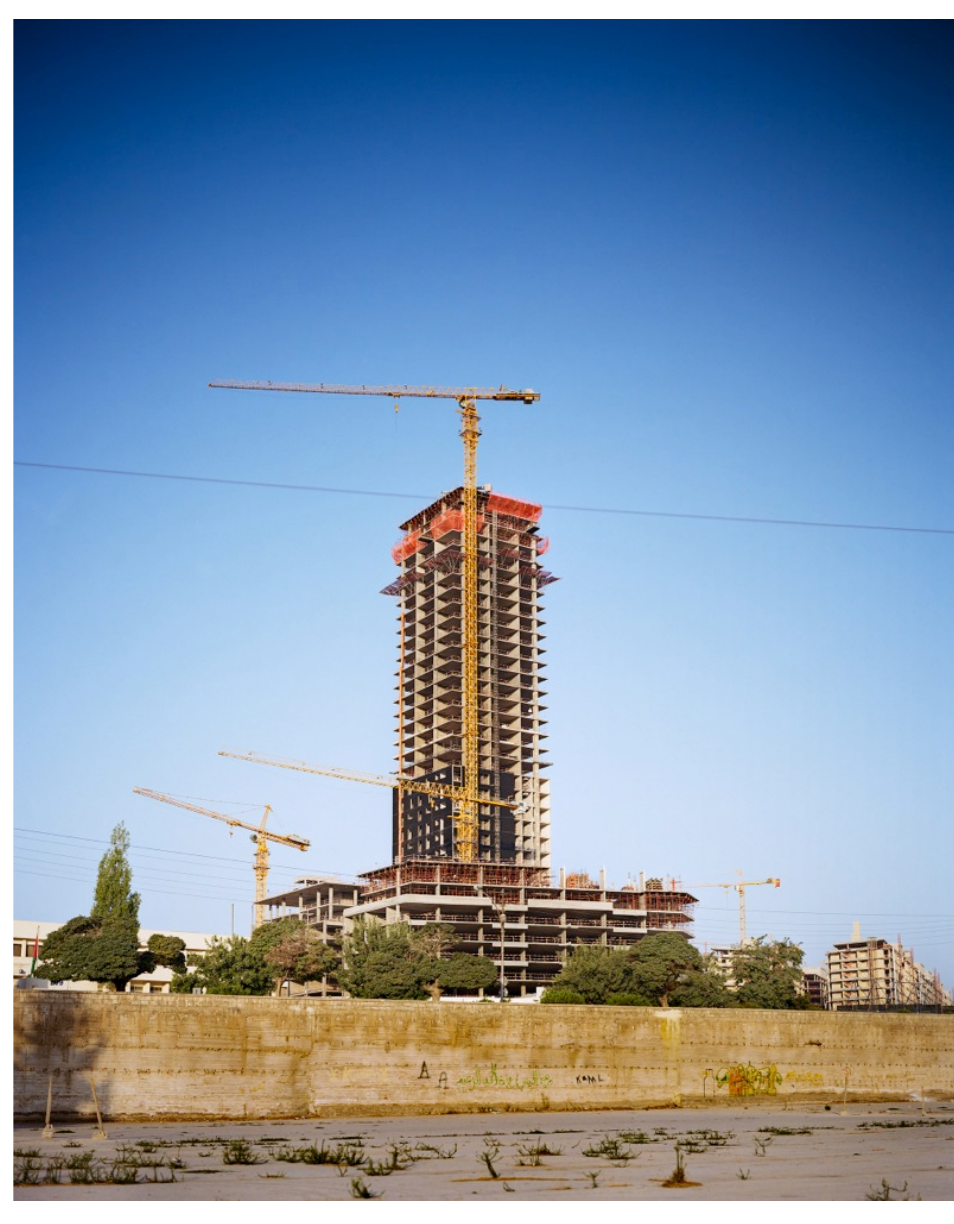
Regina Mamou, Untitled (Abdali’s Plan) from the series Mapping Collected Memory , 2009–2010. Digital C-print. 40 x 32 in. (101.60 x 81.28